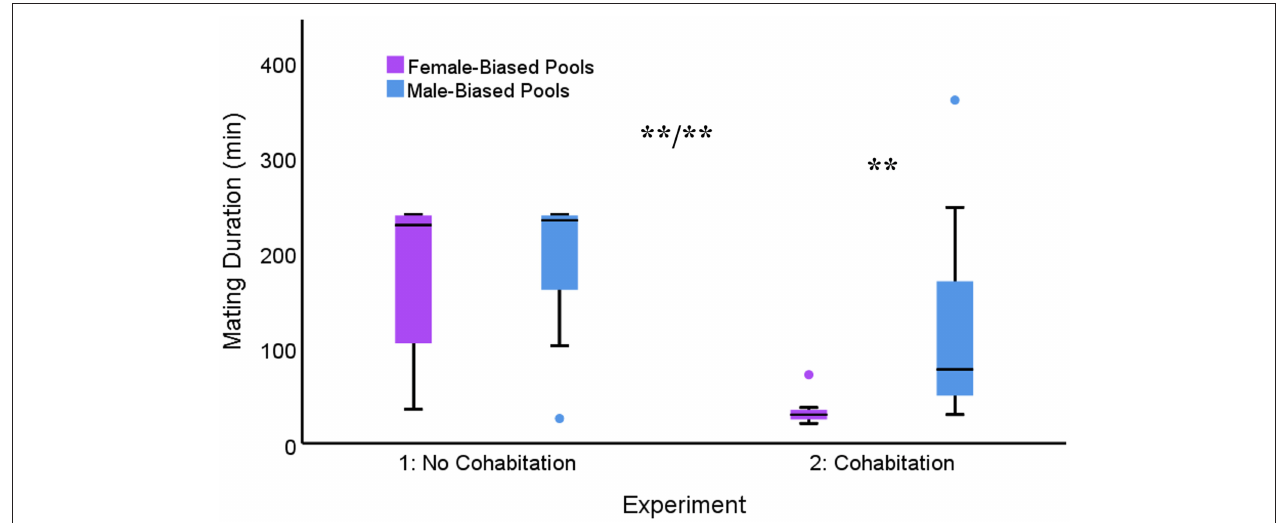
FIGURE 1 | Box plots depicting mating duration across different sex-ratio conditions for males tested in both Experiment 1 (max 240min) and Experiment 2 (max 360min). There were significant main effects for sex-ratio condition and experiment (i.e., cohabitation), as well as an interaction between these factors. Median and quartiles presented (** p <